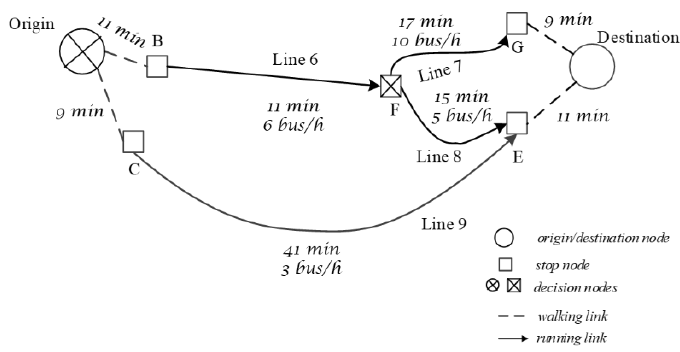
Figure 1. Example of a line-based multiservice transit network.